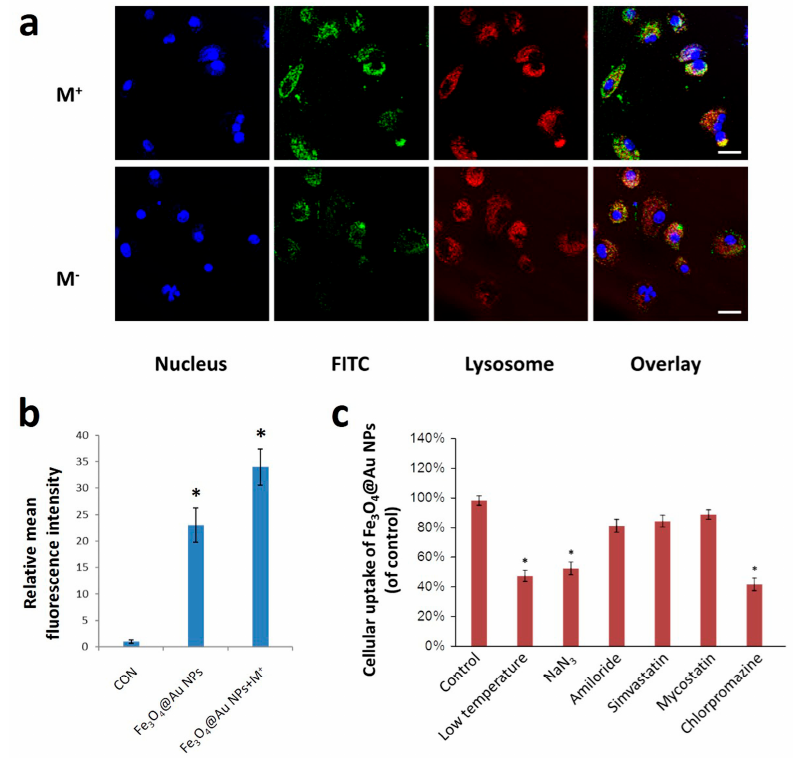
Figure 2. Cell uptake and cytotoxicity of Fe 3 O 4 @Au NPs. ( a ) Intracellular localization of endo/lysosomes (red) and Fe 3 O 4 @Au NPs (green) using confocal laser scanning microscopy images, (scale bar: 10 µ m); ( b ) Quantitative analysis of fluorescence intensity of Fe 3 O 4 @Au NPs for 3 h with or without magnetic field; ( c ) Endocytic inhibition effect after treatment with various inhibitors. * p < 0.05 versus NP group.